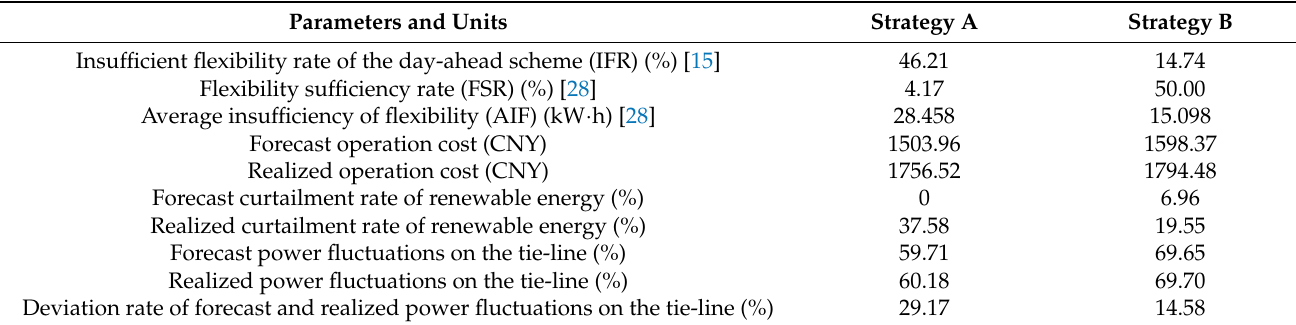
Table 5. Simulation results of Strategies A and